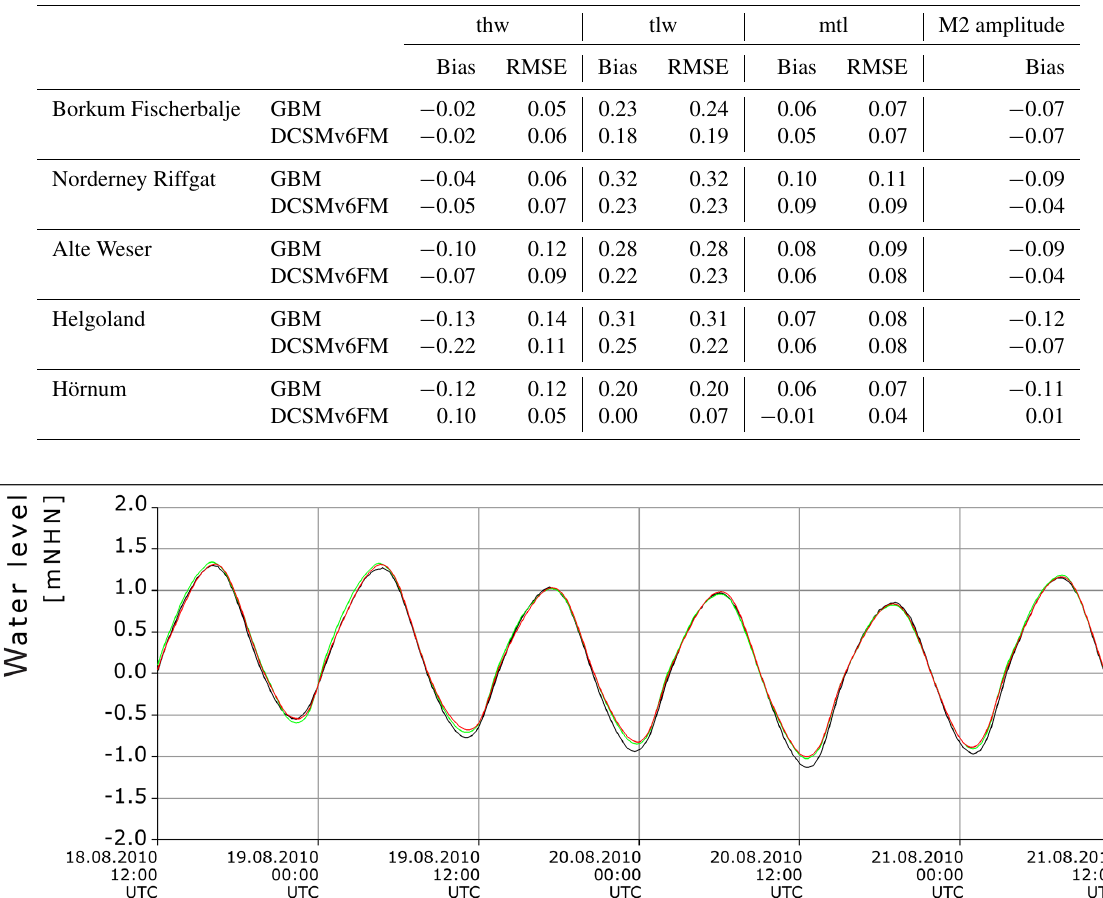
Figure 3. Water level relative to mNHN (metres above the German datum) at the station “Borkum Fischerbalje” (see Fig. 2): black: measured data, red: simulated data with the German Bight Model, green: simulated data with the